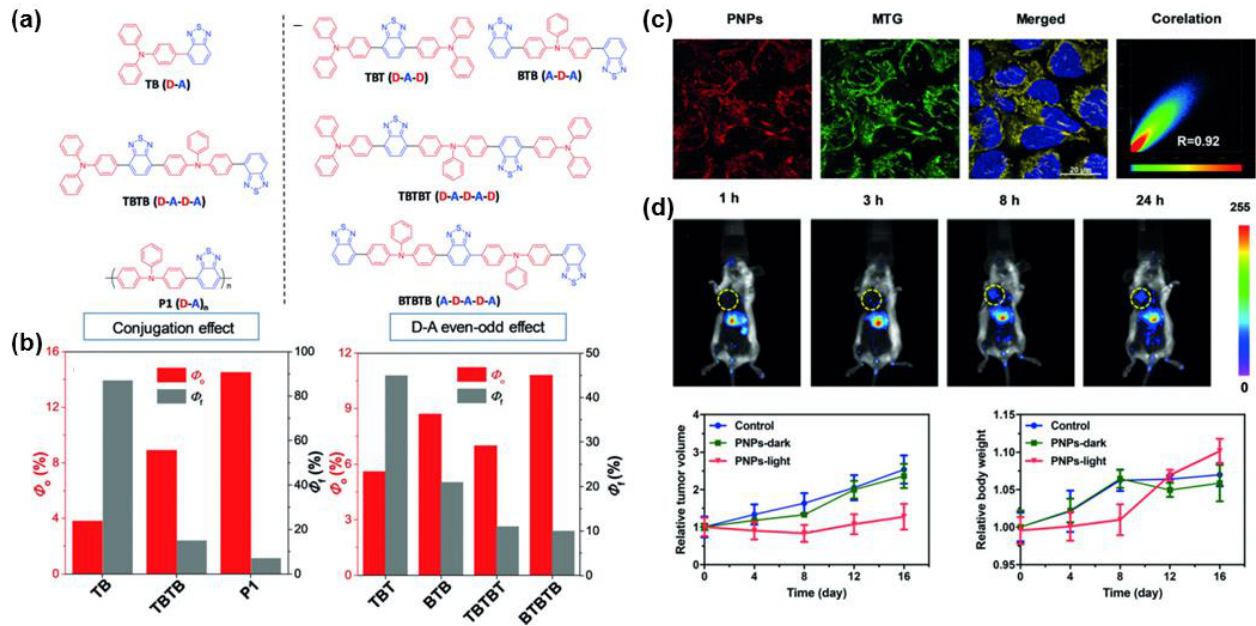
Figure 8. ( a ) The chemical structures of TB, TBTB, P1, TBT, BTB, TBTBT, and BTBTB. ( b ) 1 O 2 quantum yield ( Φ o ) and fluorescence quantum yield ( Φ f ) of the above materials. ( c ) Colocalization fluorescence image of HeLa cells. ( d ) Tumor imaging of mice and in vivo PDT effects of PNPs. Reprinted with permission from Ref. [54]. 2018, Wiley-VCH.